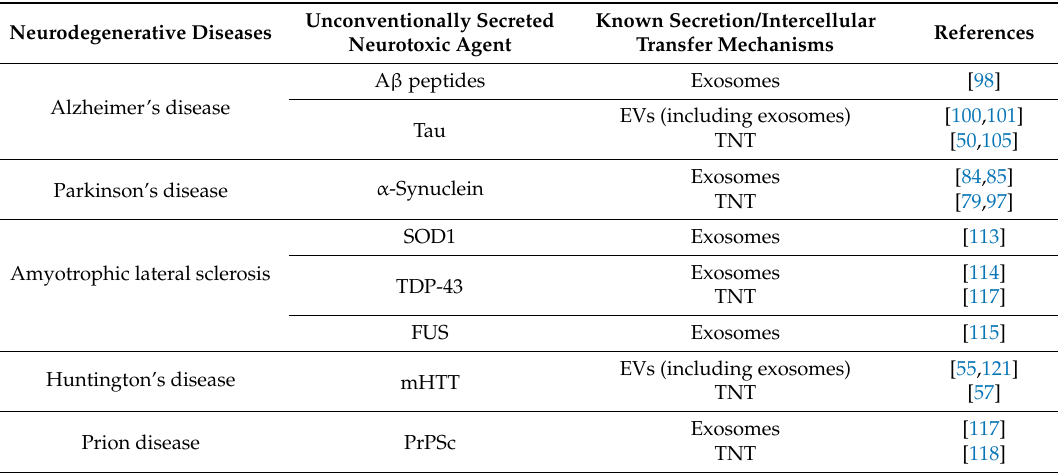
Table 1. Major neurotoxic agents that are known to be unconventionally secreted in neurodegenerative diseases. EV—extracellular vesicle; TNT—tunneling